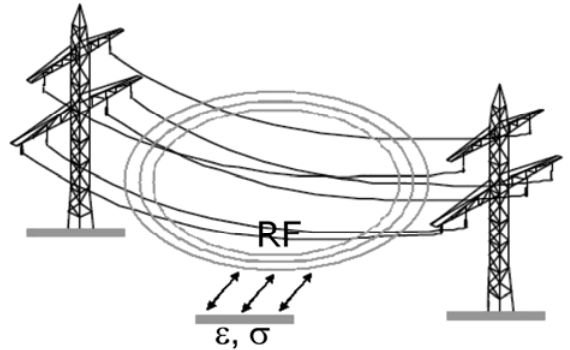
Figure 6 . Schematic principle of the ‘FLS’